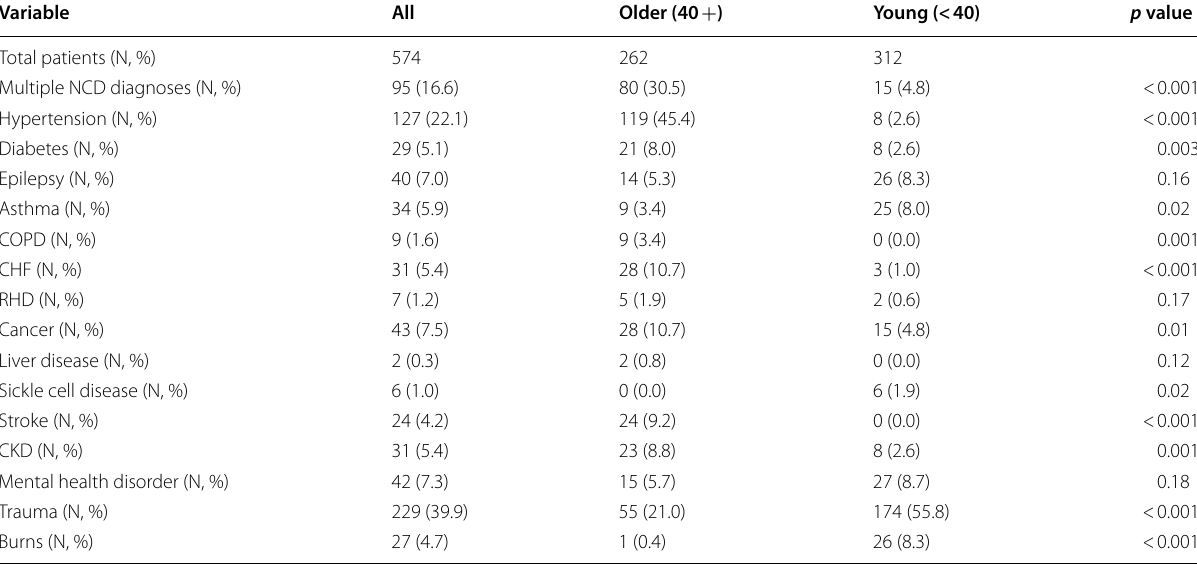
Table 2 Analysis of NCD patients by age group